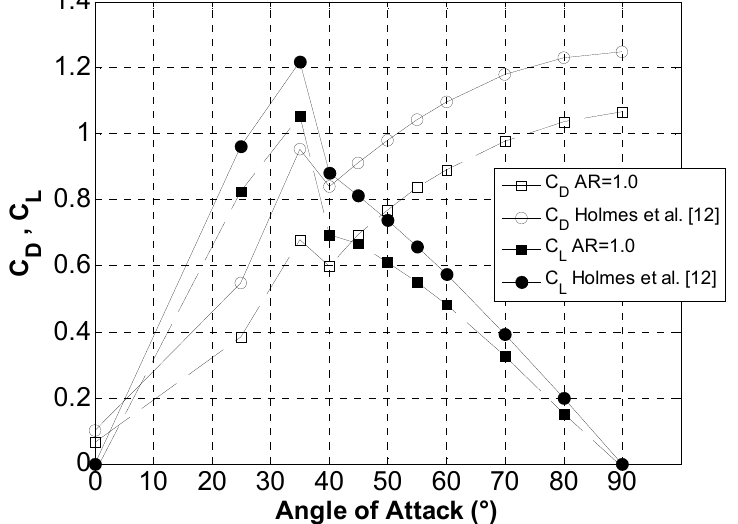
Figure 6. Free stream C L and C D for AR = 1.0 compared with Equations (1) and (2) from Holmes et al.